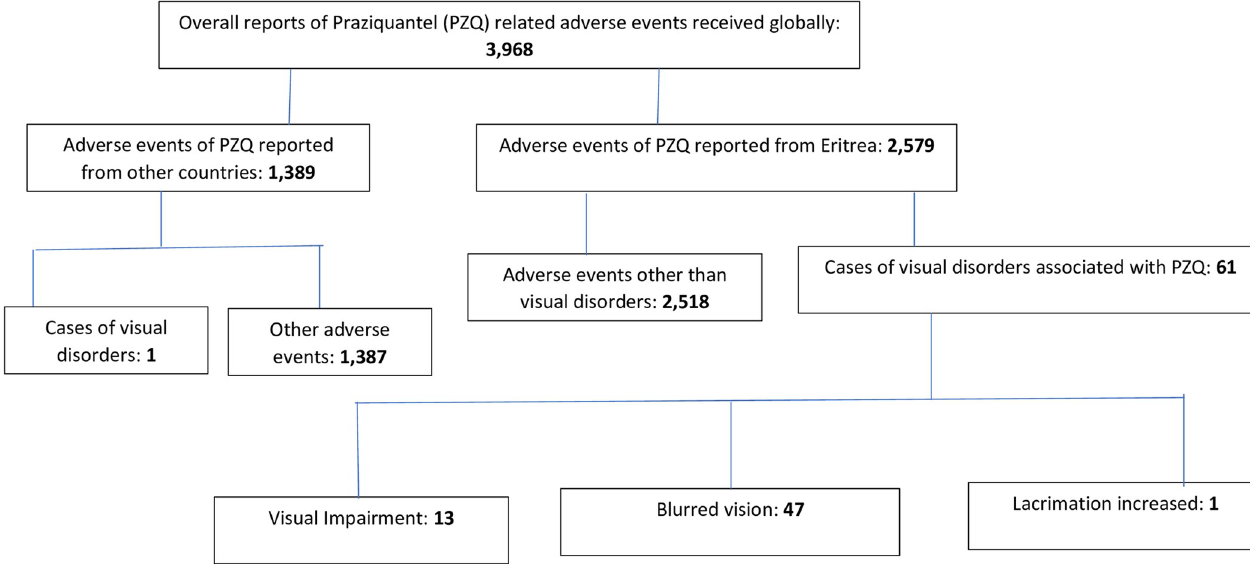
Fig 1. Summary results of Praziquantel related cases of visual abnormalities submitted from Eritrea to the WHO global individual case safety reports database.